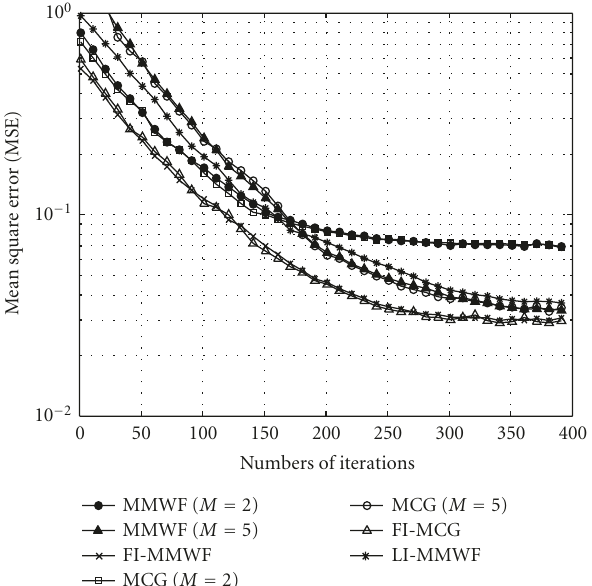
Figure 5: Mean square error versus the number of iterations for blind reduced-rank MCG-based